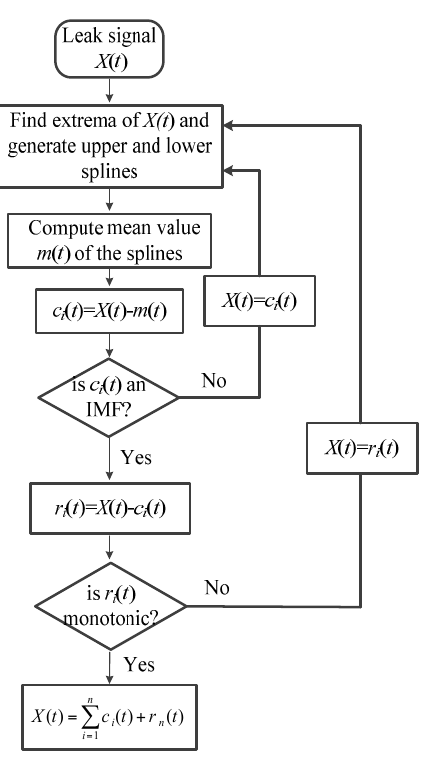
Figure 3. Flowchart of EMD.